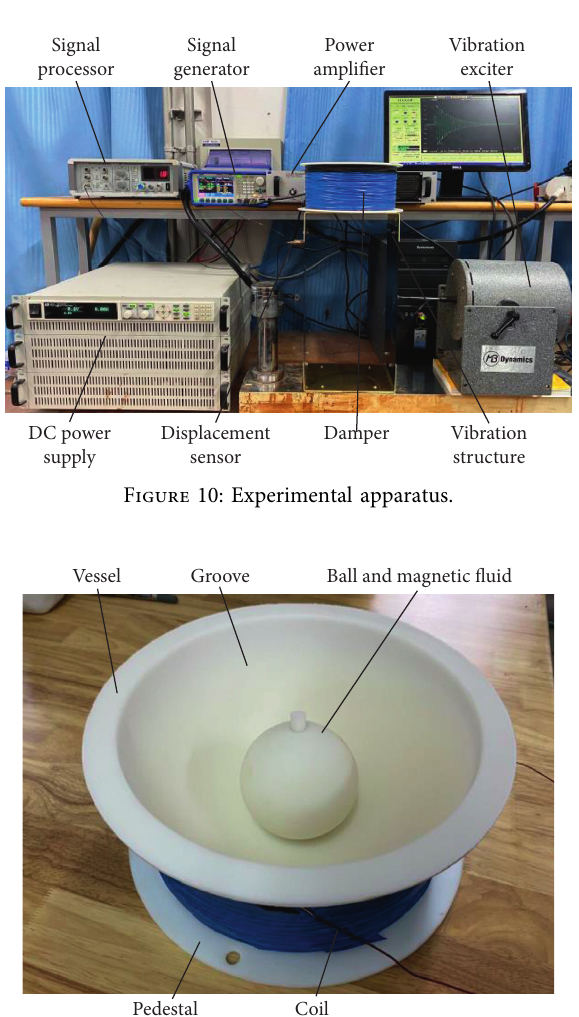
Figure 11: The experimental model of the damper.